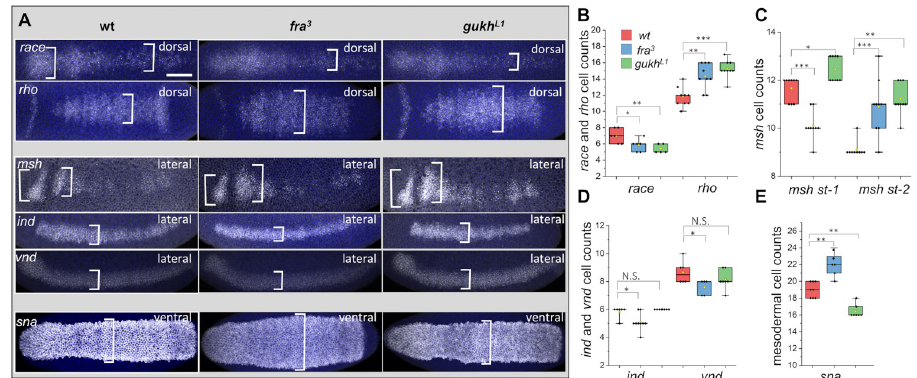
Fig 5. D/V expression domains change in fra and gukh mutants. (A) RNA in situ for race , rho , msh , ind , vnd , and sna in wild type, fra 3 and gukh L1 . Brackets, domain width. Cell counts of ectodermal expression genes race and rho (B), neuroectodermal genes msh (C), ind and vnd (D), and mesodermal gene sna (E). Asterisks, threshold values of p -values calculated with two-tail Mann–Whitney test ( � p < 0.05, �� p < 0.01, ��� p < 0.0001). N.S., not significant. Yellow dots, mean values. Scale bar, 60 μ m. Metadata for the graphs shown in B–E can be found at Supporting information S1 Metadata. D/V, dorso-ventral; FRA, frazzle; GUKH, guk-holder; ind, intermediate nervous system defective; msh, muscle segment homeodomain; sna, snail; vnd, ventral nervous